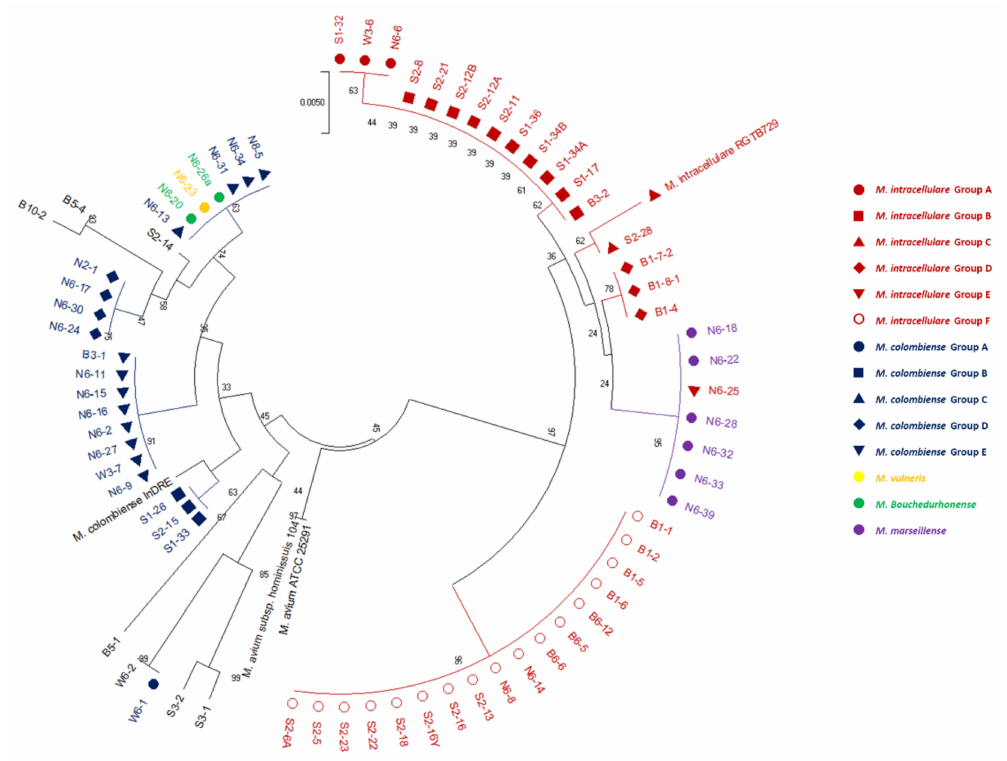
Figure 5. Phylogenetic analysis of MAC isolates in South Korean soils based on the hsp65 gene sequences of the isolates and previously reported strains in NCBI GenBank. The tree was created using the neighbor-joining method, and bootstrap analysis was performed from 1000